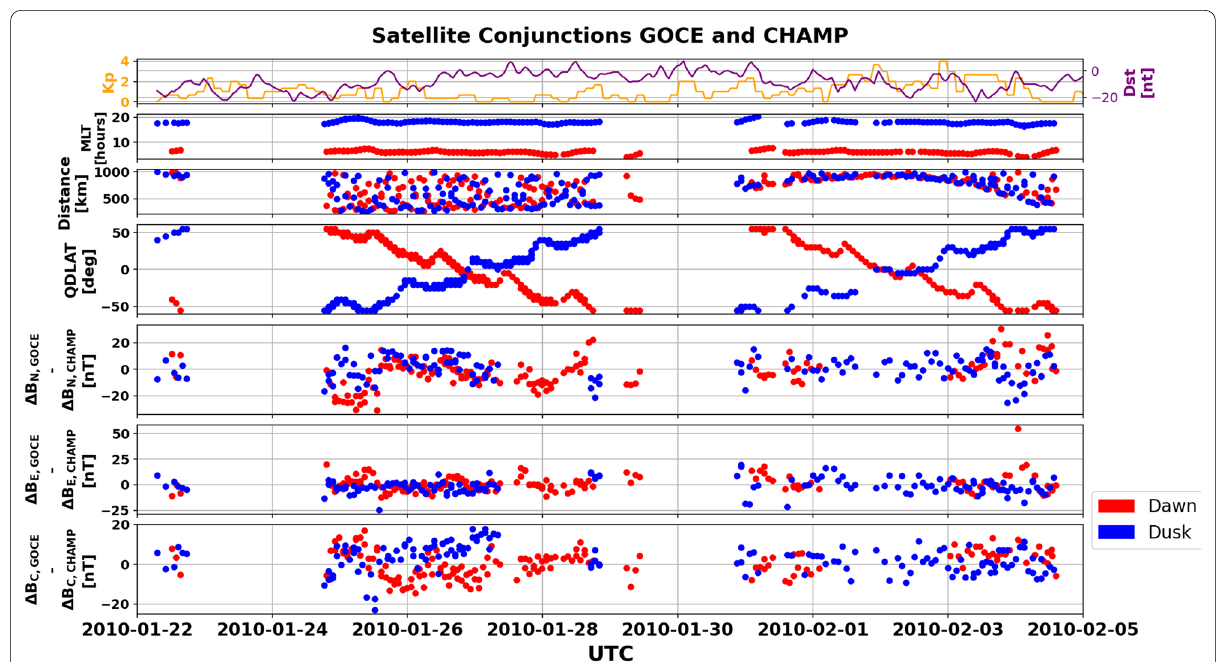
Fig. 11 Conjunctions for co‑rotating GOCE and CHAMP satellites for the period of 2010‑01‑22 to 2010‑02‑05 are shown. The first panel shows the geomagnetic environment, indicators Kp and Dst show the geomagnetic quiet time. The second panel shows the MLT with descending dawn orbits in red and ascending dusk orbits in blue given by quasi‑dipole latitude (QDLAT) in the 4th panel. The 3rd panel shows the distance between the GOCE and CHAMP satellites. The three bottom panels show residuals for GOCE with respect to the CHAOS7 reference model subtracted by residuals for CHAMP with respect to the CHAOS7 model for the North, East and Center components from top to bottom in nT